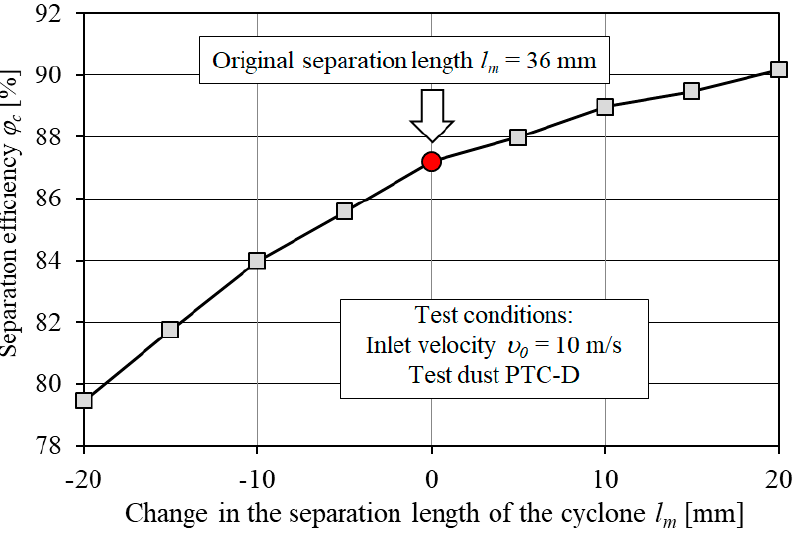
Figure 11. Cyclone separation efficiency φ c depending on the change of the cyclone ′ s separation length l m .